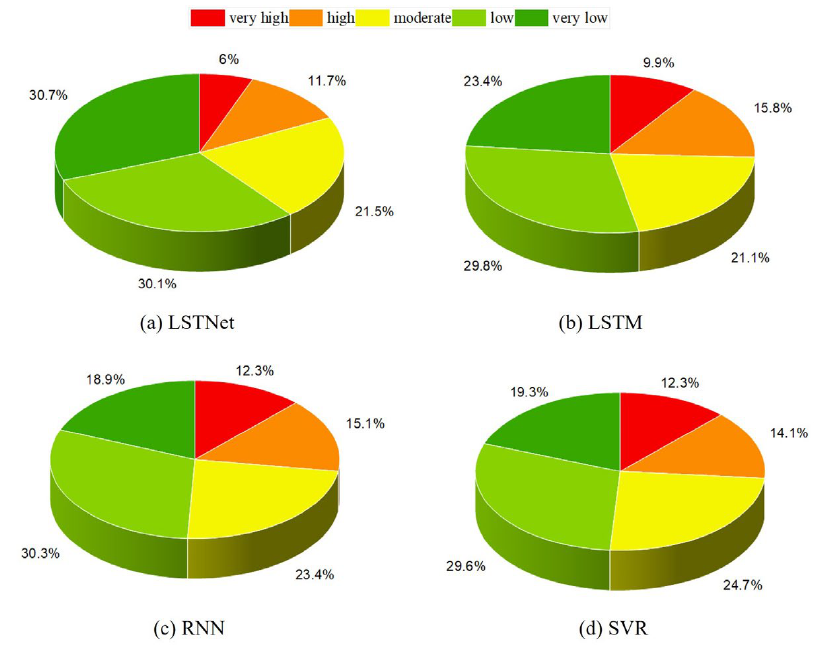
Figure 9. Grade distribution of risk maps predicted by four models.